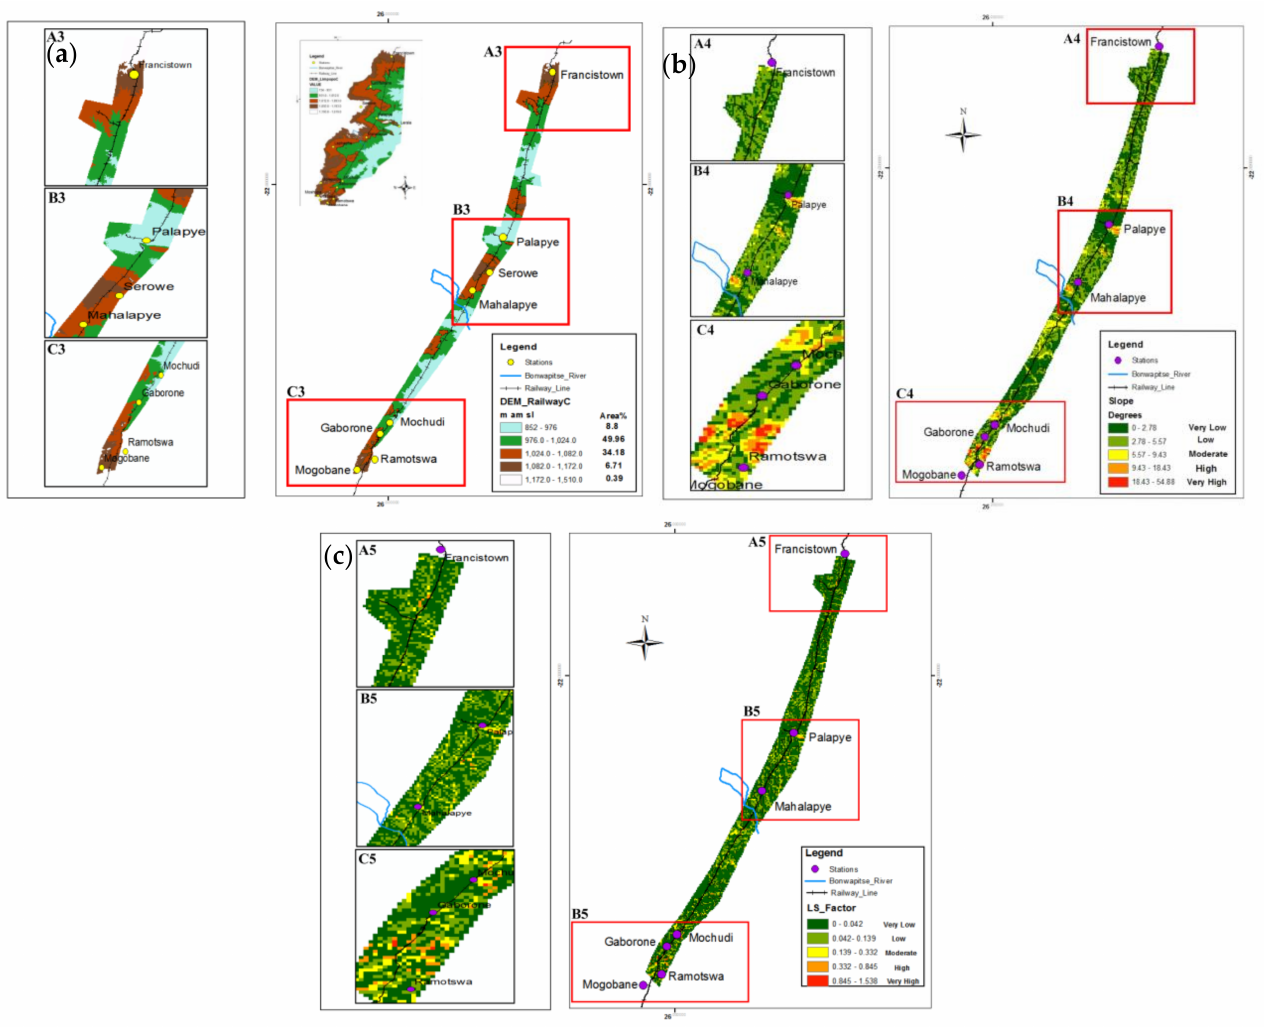
Figure 6. ( a ) Elevation (DEM) variability within the BRC. (Inset: DEM for the BLRB). ( b ) Slope varia- tions within the BRC. ( c ) LS-factor map of the BRC and significance in contributing to soil